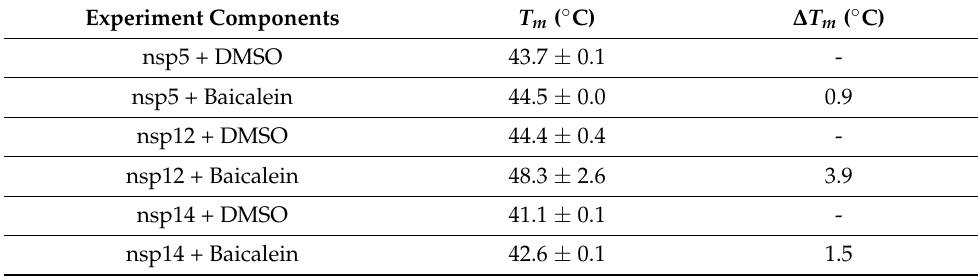
Table 3. Thermal shift assay results. Binding of baicalein to SARS-CoV-2 RdRp (nsp12), 3CL protease (nsp5) and nsp14 as another important nonstructural protein of SARS-CoV-2 was tested. Baicalein caused a Δ Tm of 3.9 °C of nsp12, demonstrating strong binding to the main component of the SARS-CoV-2 RdRp.